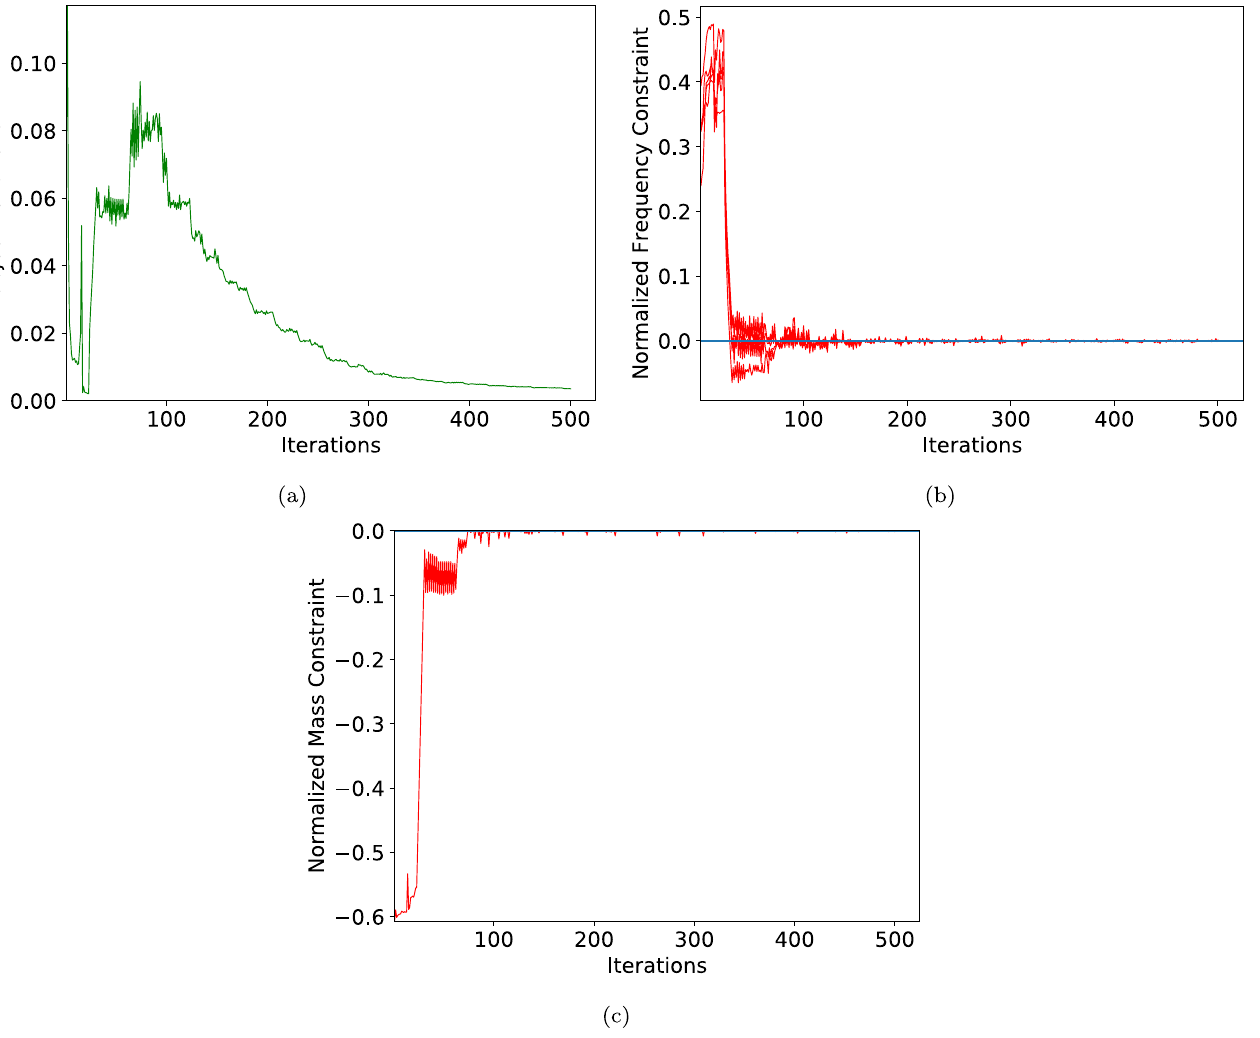
Fig. 3. Evolution of the best found design with the number of iterations using COBYLA for N = 5 . The objective function (a), the frequency constraints (b) (Eq. (3)), and the mass constraint (c) (Eq. (6)) are plotted as a function of the iterations. tolerance on the size of COBYLA’s trust region to 10 − 3